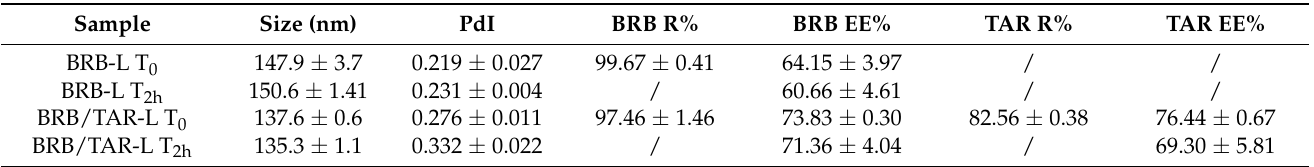
Table 4. Physical and chemical characterization in terms of size, PdI, EE%, and R%, of the dialyzed nanoliposomes BRB-L and BRB/TAR-L at time zero (T 0 ) and after 2 h incubation (T 2h ). All results are expressed as mean ± SD ( n = 3). Sample Size (nm) BRB-L T 2h 150.6 ± 1.41 BRB/TAR-L T 0 137.6 ± 0.6 BRB/TAR-L T 2h 135.3 ±